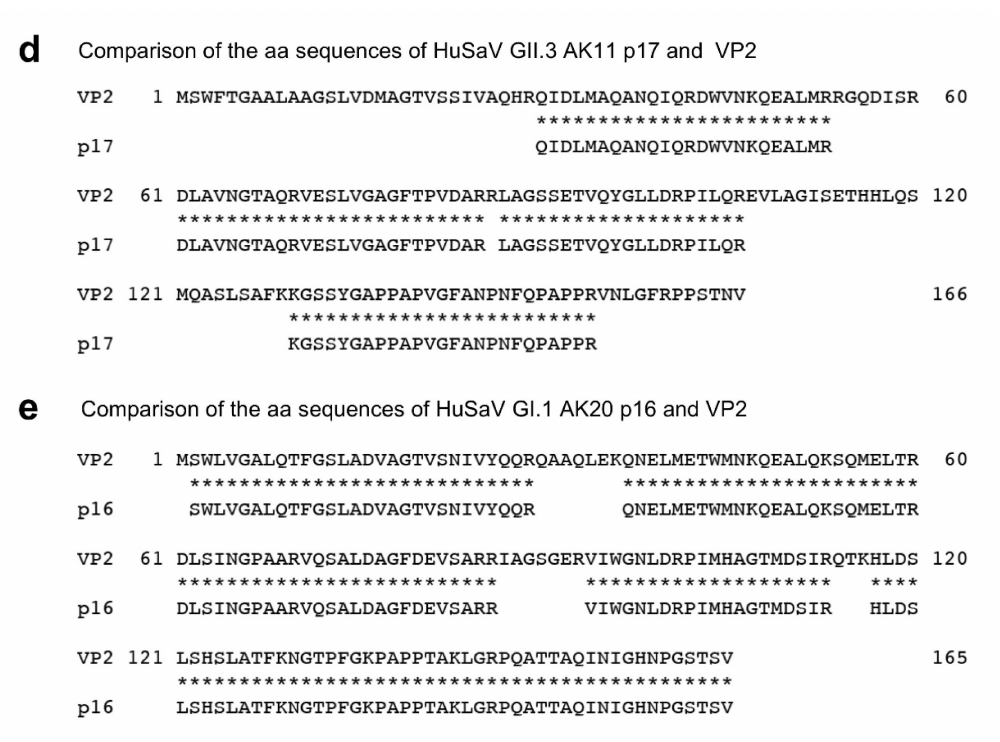
Figure 3. Proteins analyses of the p17 and p16. Purified HuSaV GI.1 AK20 virions and HuSaV GII.3 AK11 virions were analyzed by SDS-PAGE followed by CBB staining ( a ). The ratio of the protein content between p58 and p17 of HuSaV GII.3 AK11 ( b ), and that between p58 and p16 of HuSaV GI.1 AK20 ( c ) were quantitated by Image software ver. 6.1 based on the band intensities. The identified aa sequences of p17 was compared with those of VP2 of HuSaV GII.3 AK11 ( d ), and the aa sequences of p16 was compared with those of VP2 of HuSaV GI.1AK20 ( e